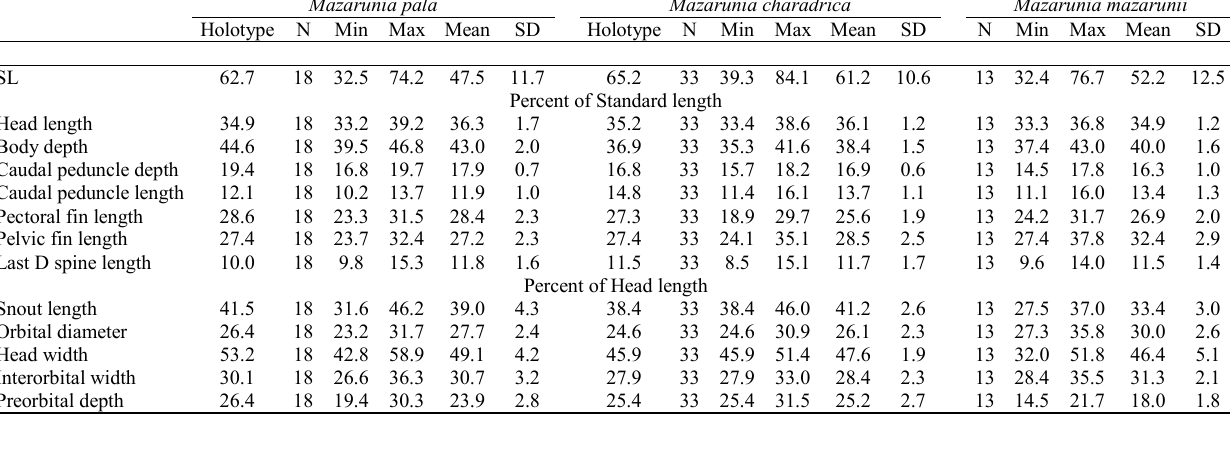
Table 1. Morphometric data for all species of Mazarunia . SD = Standard deviation; N = number of specimens